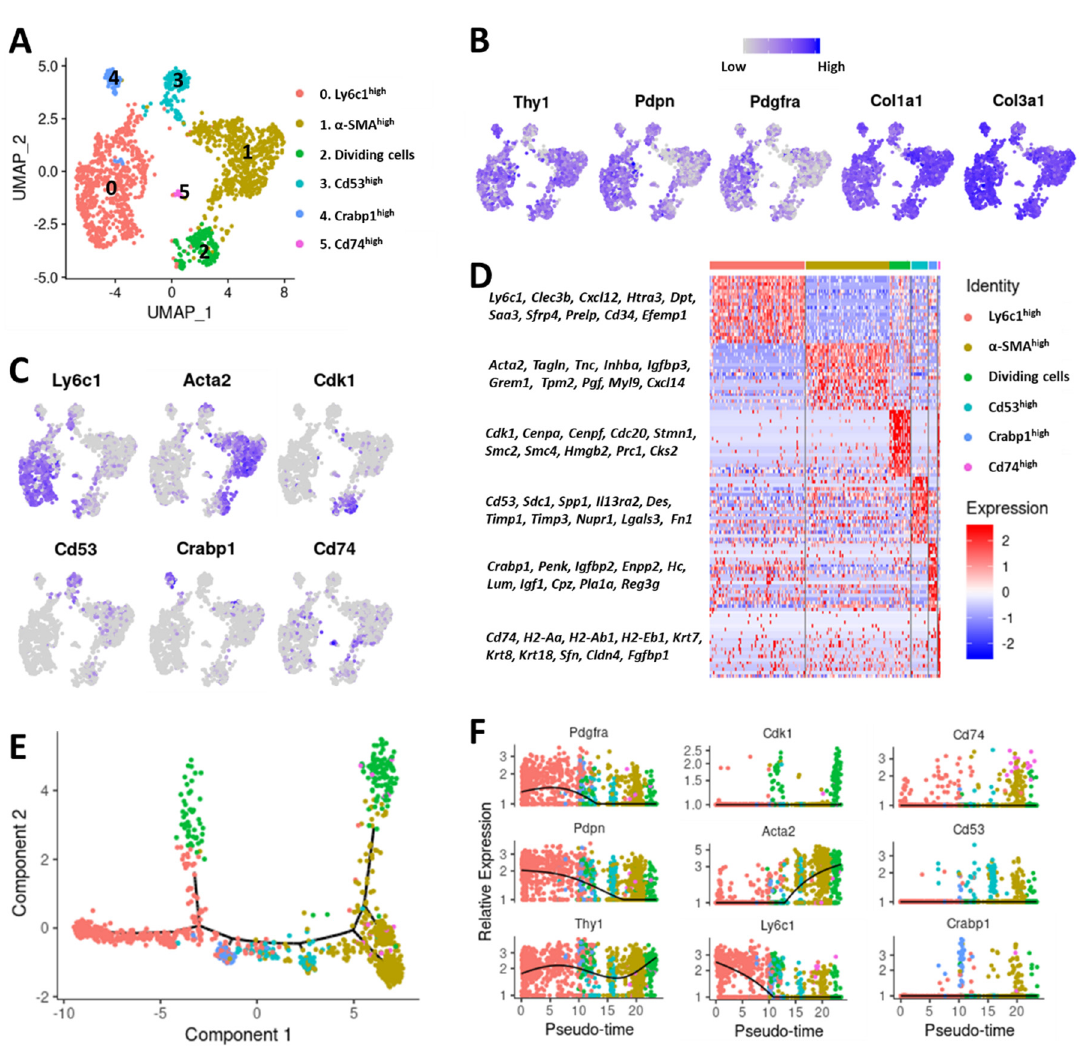
Figure 2. Characterization of CAF subtypes in 4T1 breast cancer. ( A ) Cell clusters from 10x Genomics scRNA-seq analysis visualized by UMAP. Colors indicate various CAF subtypes. ( B ) Feature plots showing the expression of commonly used CAF markers in various CAF subtypes. Legend shows a color gradient of normalized expression. ( C ) Markers of various CAF subtypes that were used to denote each subtype. ( D ) Heatmap showing a subset of genes differentially expressed between the 6 CAF subtypes. ( E ) Monocle pseudospace trajectory colored based on CAF clusters in ( A ). ( F ) Expression of CAF markers on a pseudotime scale (colored based on CAF clusters in ( A )).